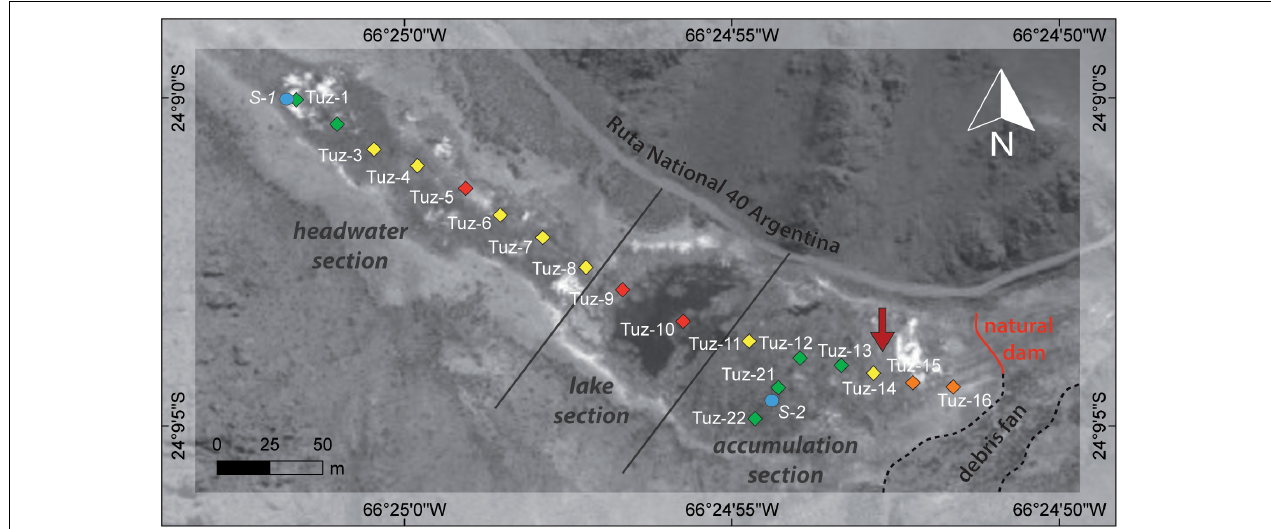
FIGURE 8 | Location of water samples from October 2013 on the CTP. Colors indicate relative 18 O enrichment in the samples, i.e., the degree of evaporation (green: low or absent evaporation, yellow: slight evaporation, orange: medium evaporation, red: strong evaporation). Diamonds indicate surface peatland samples (Tuz), blue circles (S1 and S2) indicate the location of the springs, the red arrow the location of core Tuz-694. The debris fan (dashed line) presumably favors the development of the natural dam (red line). The main sections of the peatland are illustrated according to Schittek et al. (2016) (data source: